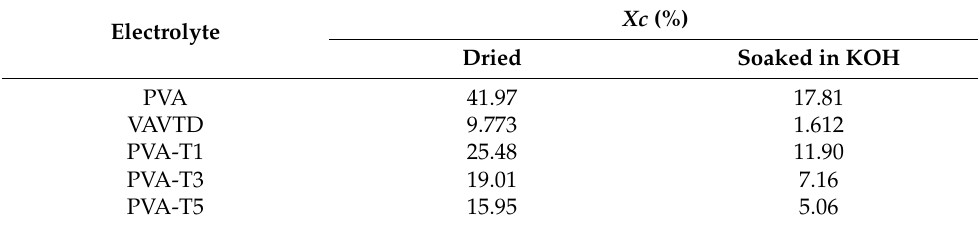
Table 1. The Xc for each electrolyte calculated by the deconvoluted method.